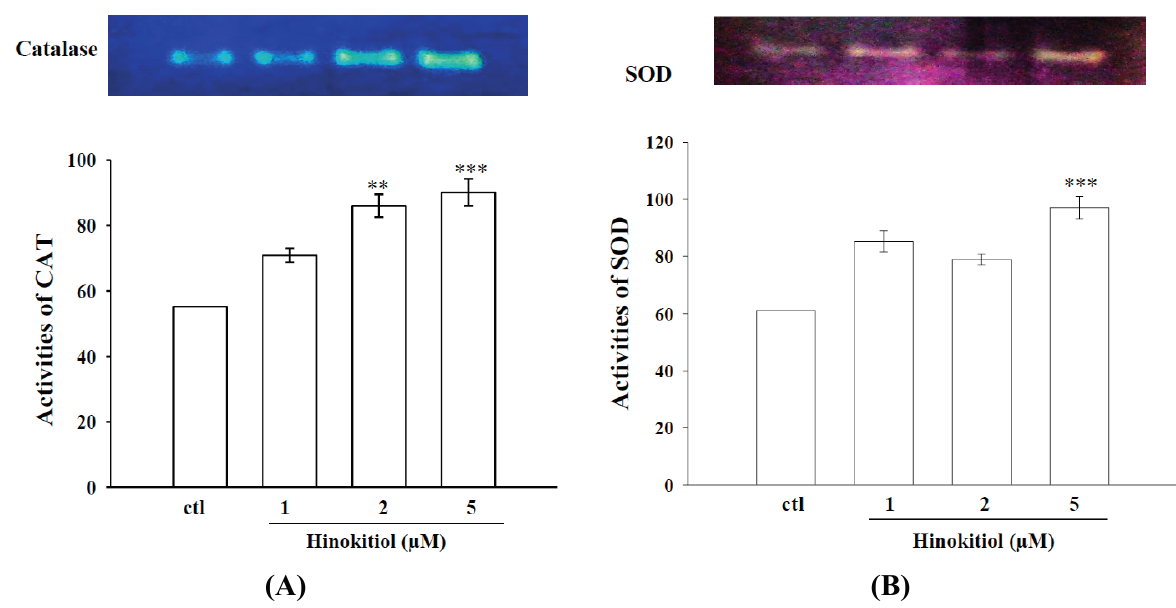
Figure 3. Effects of hinokitiol on CAT and SOD activity in B16-F10 melanoma cells. B16-F10 melanoma cells were treated with different doses of hinokitiol (1–5 µM) in serum-free media for 24 h. Cell lysates were obtained for the assay of CAT ( A ) and SOD ( B ) activities by using native-PAGE. The figures are representative examples of three independent experiments. * Indicates the values are significantly different from the control (** p < 0.01, *** p <